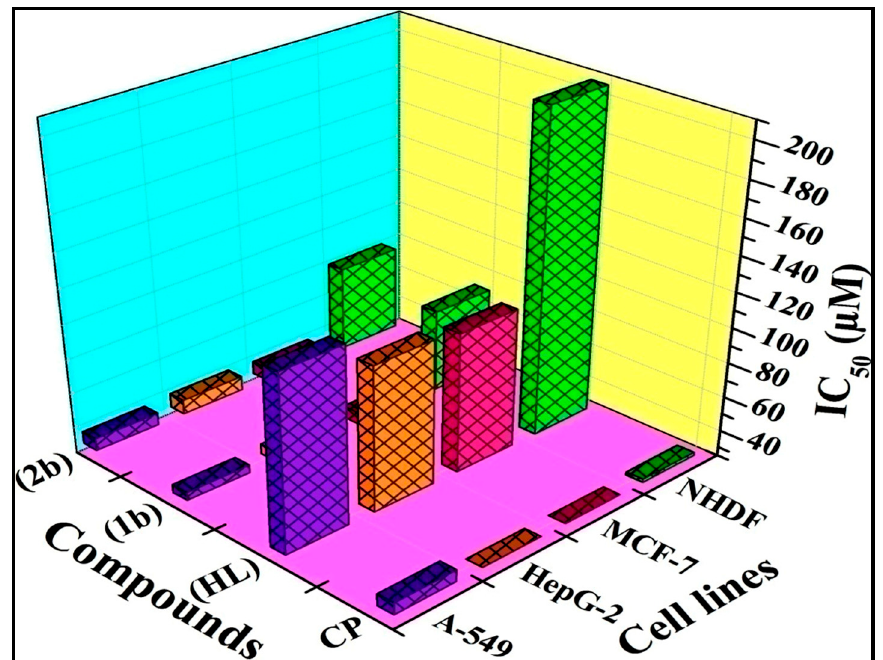
Figure 13. The comparison of cytotoxic effects of ligand ( HL ) and its complexes ( 1b – 2b ) with standard drug cisplatin ( CP ) against cancer and normal cell lines. Error limits ± 2.5–5.0% ( p ≤ 0.05).